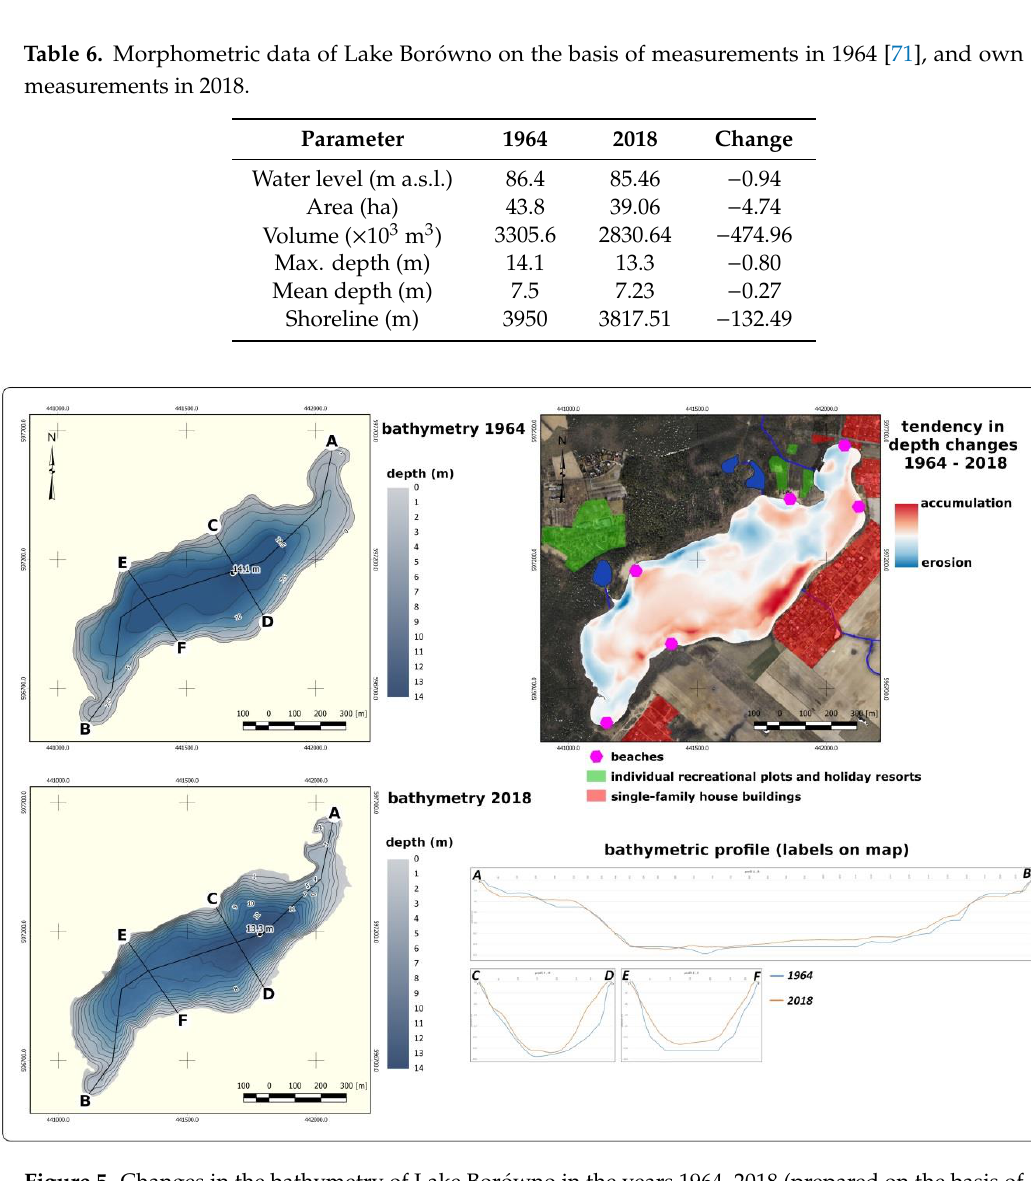
Figure 5. Changes in the bathymetry of Lake Borówno in the years 1964–2018 (prepared on the basis of the data of IRŚ [63,71], and own measurements).